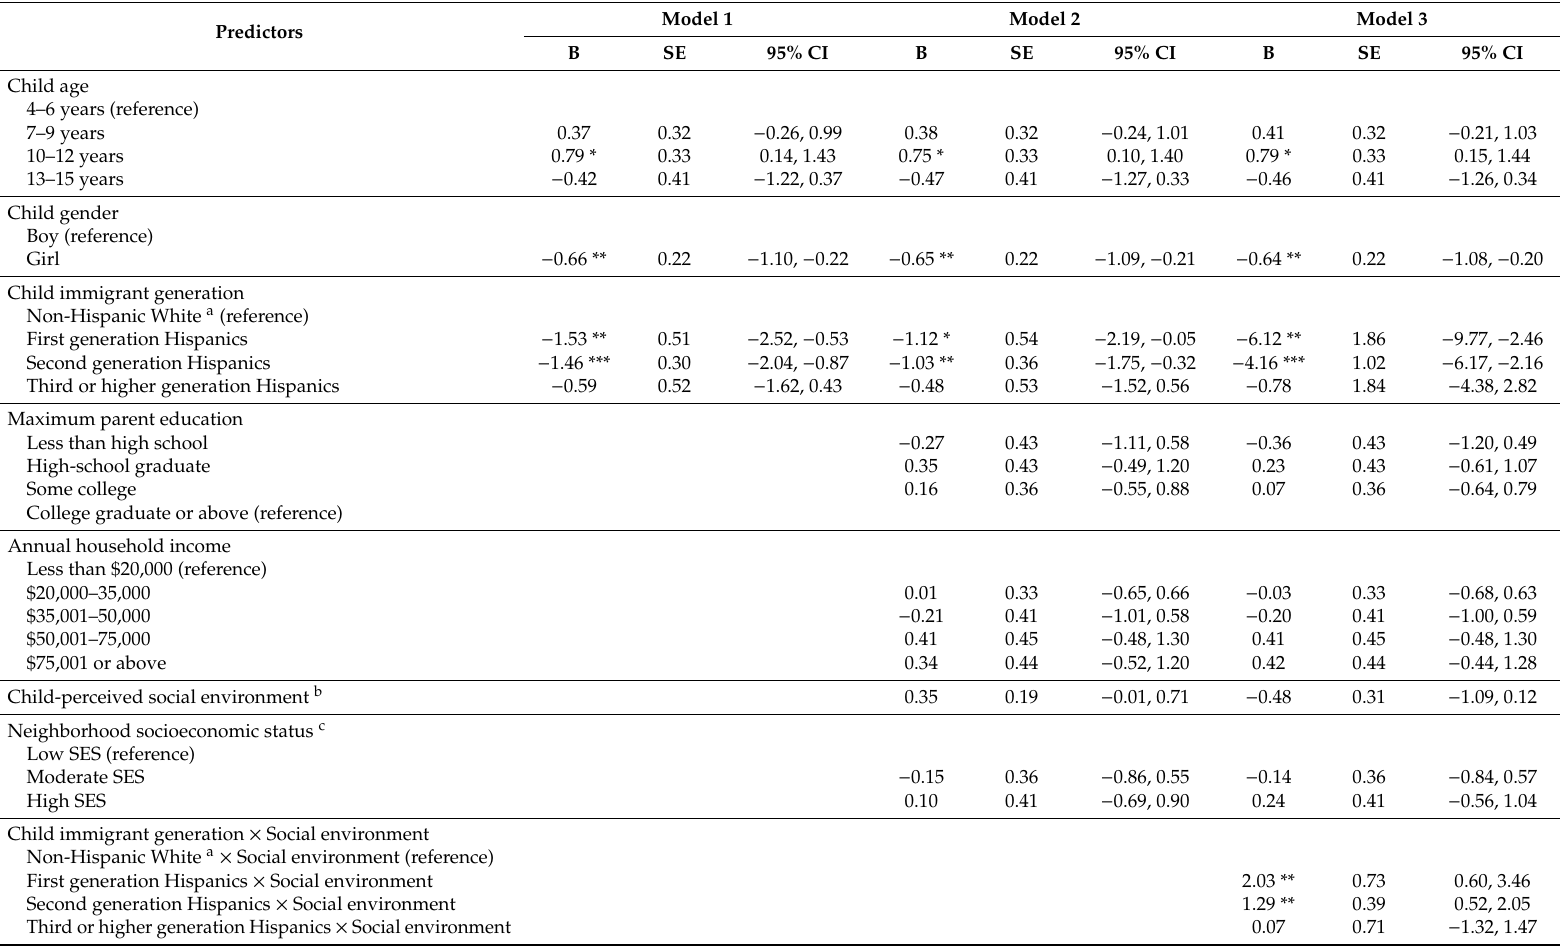
Table 4. Results of multilevel modeling assessing associations between child immigrant generation and physical activity (times per week), n =